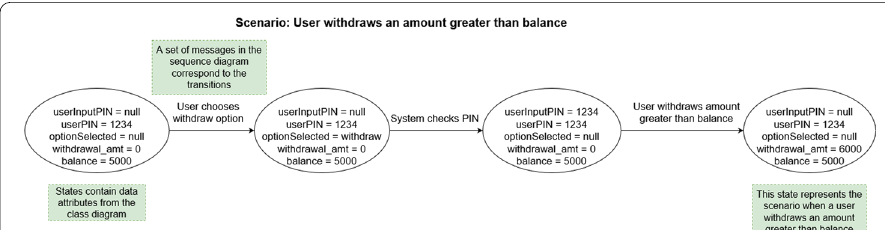
Fig. 1 The model state diagram for a given scenario generated using the design tracing strategy